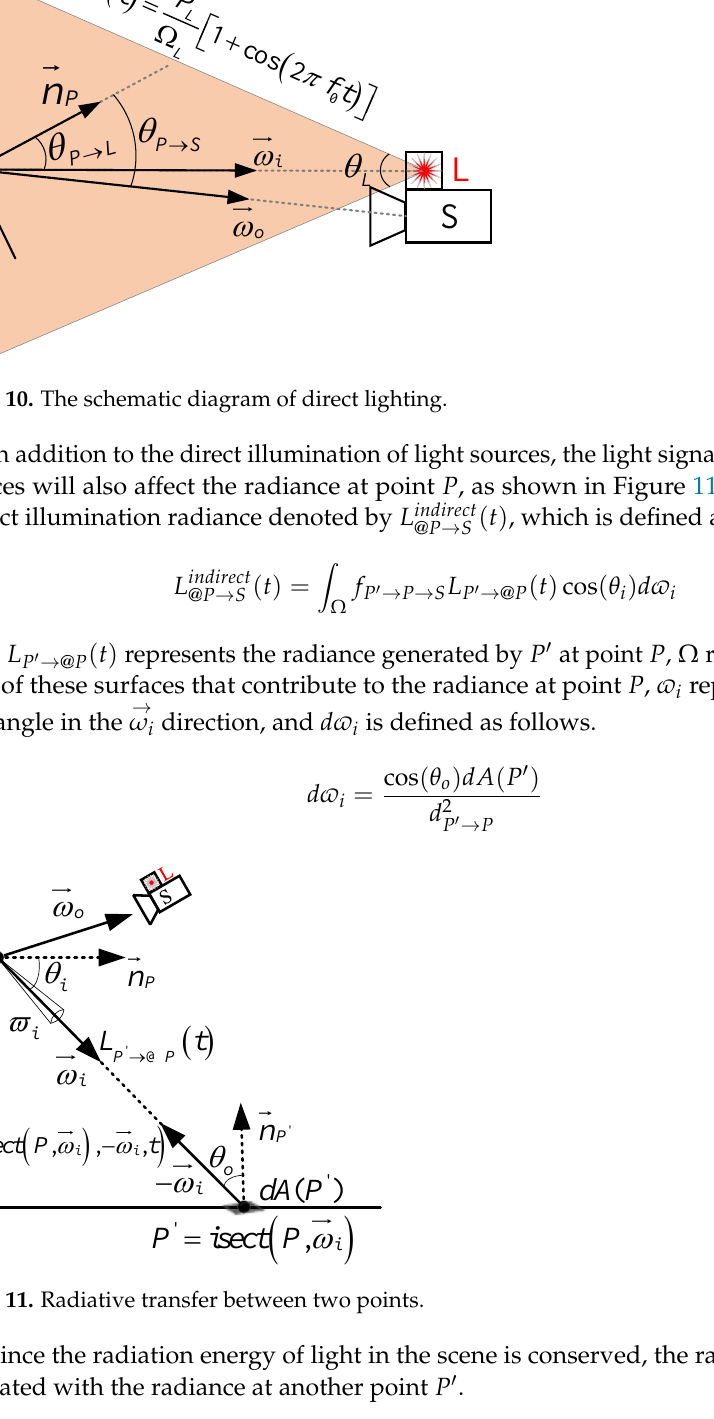
Figure 11. Radiative transfer between two points.